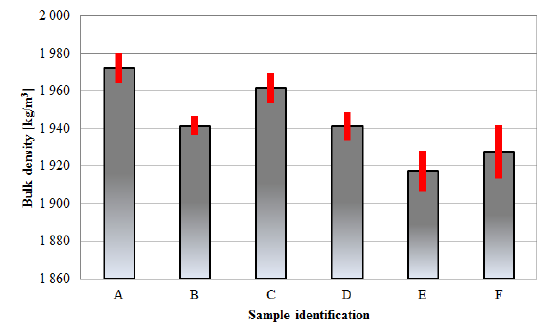
Figure 1. Final bulk density of the samples.